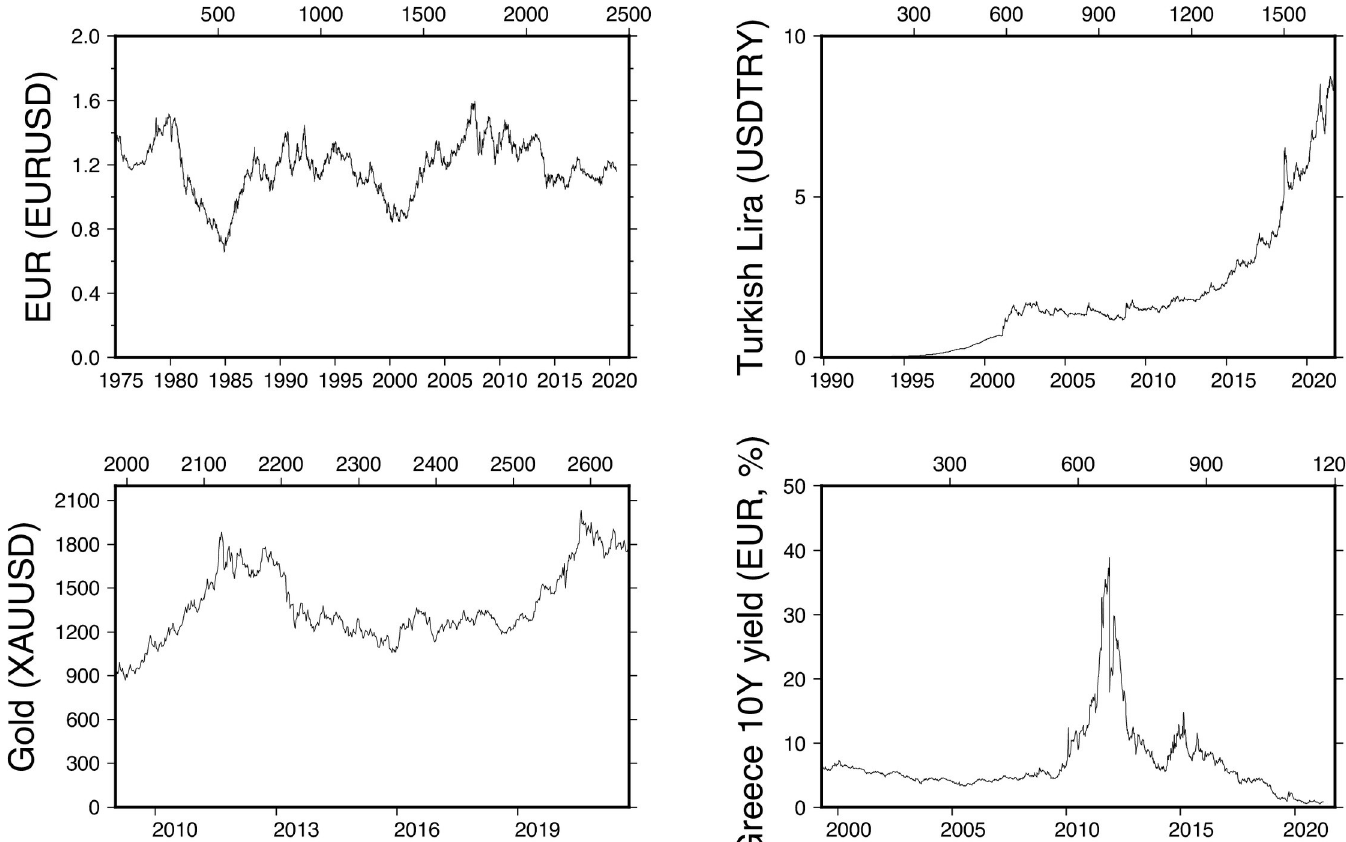
Fig 6. Time series of Gold (XAU), currencies (TRY and EUR) and 10YR Greek bond yields (weekly data). Currencies and bond yields show very diverse patterns due to different economic, market and political contexts. Only 10yr Greek Gov. bond yields time-series shows similarities with BTC pricing episodes until the peak is reached.